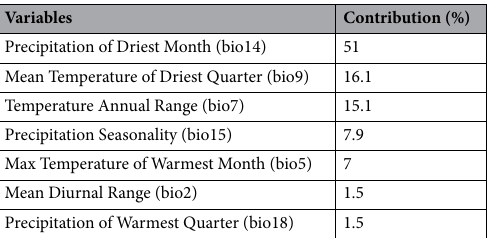
Table 2. Contribution of the seven bioclimatic variables to the MaxEnt prediction model.